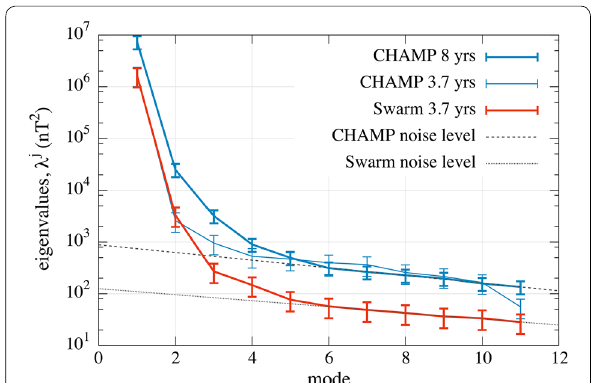
8 year) dataset (thick Fig. 3 Singular spectra for CHAMP full ( τ W = 3.7 year) dataset (thin blue) and blue), CHAMP shortened ( τ W = Swarm (thick red), in logarithmic scale. The standard error associated with each eigenvalue is given by North’s rule of thumb to help identify modes that can be separated. In grey, the straight lines fitted to the noise